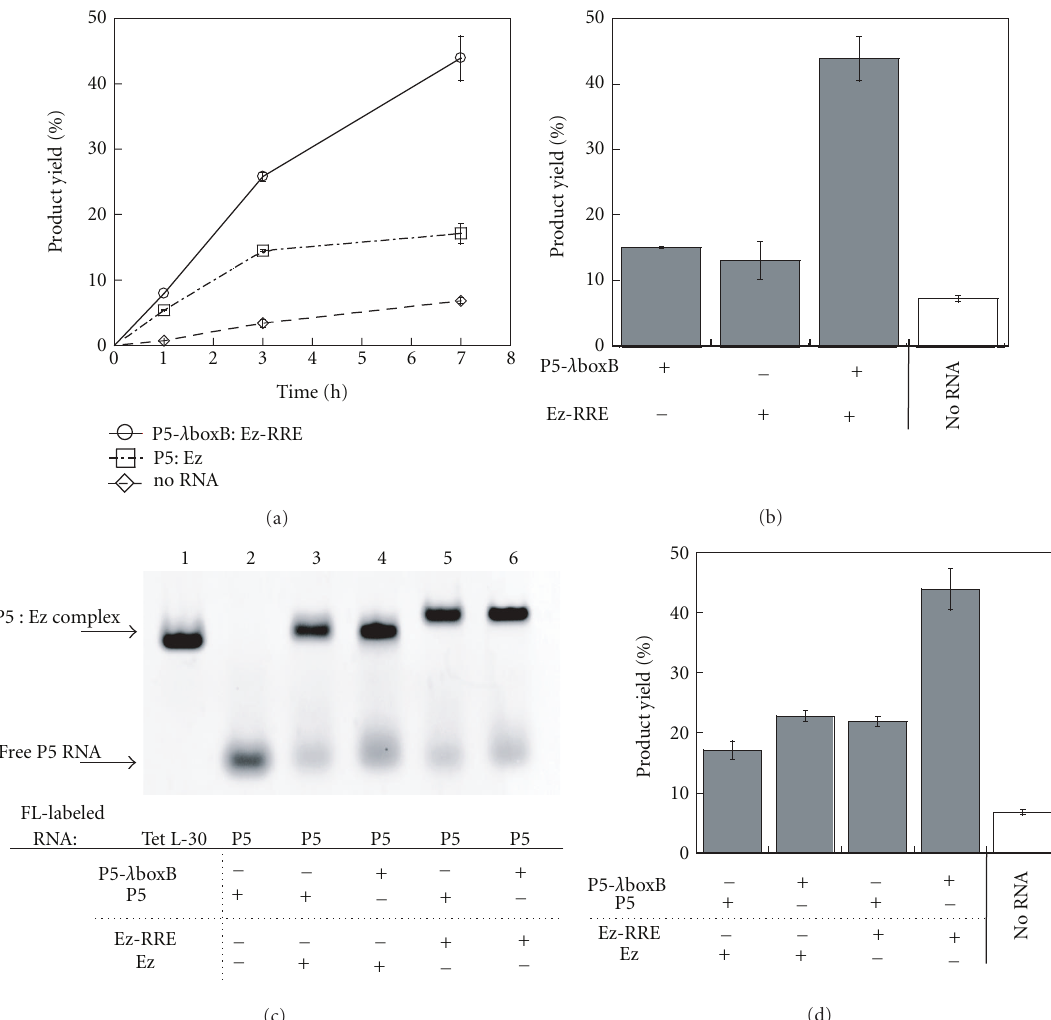
Figure 5: Dissection of the template RNA complex (P5- λ boxB: Ez-RRE) for the chemical ligation between λ N-peptide1 and rev-peptide2. (a) Time course of ligation reaction (with 7.5 μ M each peptide) in the presence of 10 mM Mg 2+ . Reactions were carried out with template RNA having PRM (P5- λ boxB:Ez-RRE) and lacking PRM (P5: Ez), and also without RNA template. (b) The contribution of the template subunit having PRM (P5- λ boxB and Ez-RRE subunits). Reactions were carried out for 7h in the presence of 10 mM Mg 2+ ions. (c) E ff ects of PRMs on the P5: Ez complex formation. Mobility shift assay was carried out with native gal electrophoresis in the presence of 10 mM Mg 2+ ions. To visualize RNA molecules on the gel, the 3 (cid:2) ends of FL-labeled RNAs were labeled with BODIPY. (d) The contribution of PRMs in the template ability of the two-piece RNA complex (P5- λ boxB:Ez-RRE). Reactions were carried out for 7h in the presence of 10 mM Mg 2+